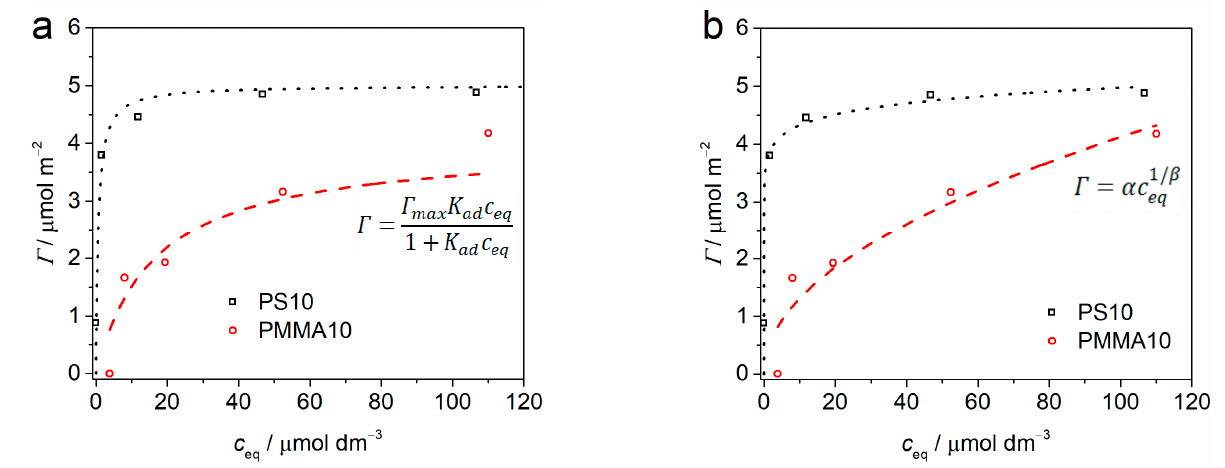
Figure 2. ( a ) Langmuir and ( b ) Freundlich adsorption isotherms for cypermethrin on 10 μ m polystyrene (PS10) and polymethylmethacrylate (PMMA10) microparticles. Table 1. Langmuir (maximal surface concentration Γ max , adsorption constant K ad ) and Freundlich ( α , β ) adsorption isotherm parameters for microplastic-adsorbed cypermethrin.